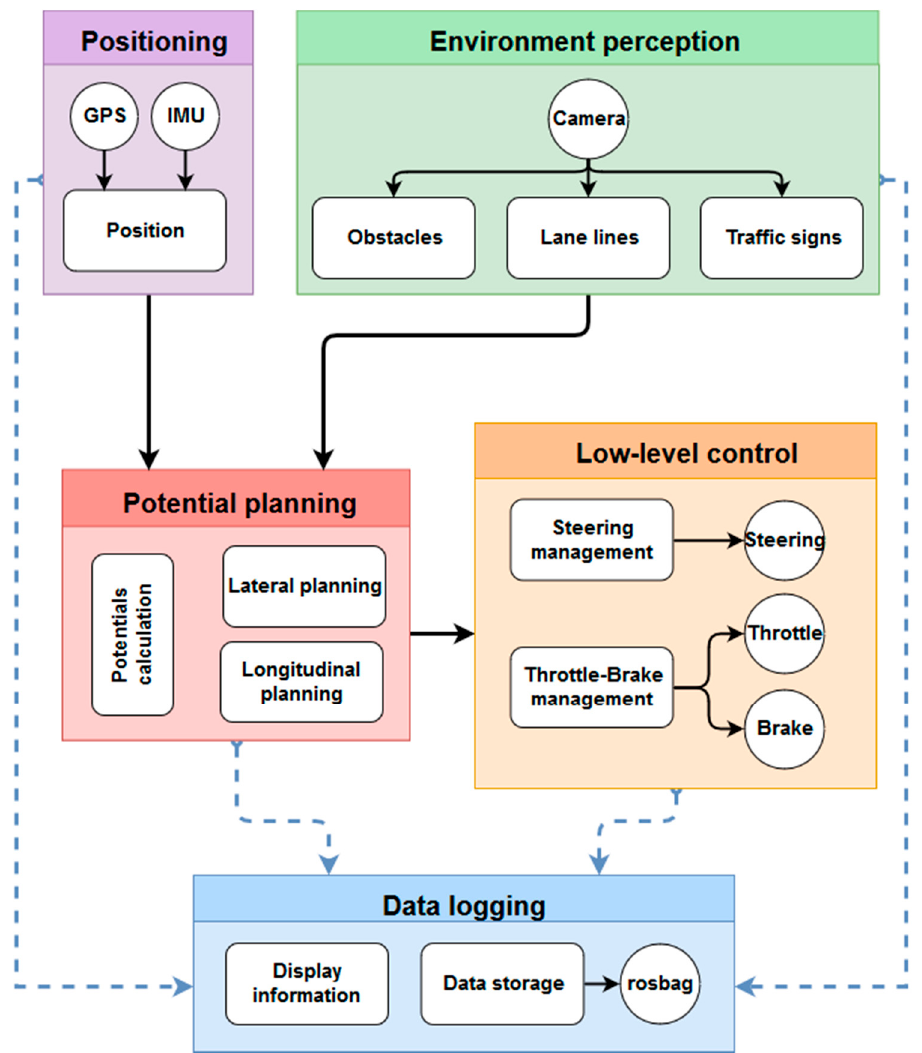
Figure 7. General diagram of the software architecture layers.